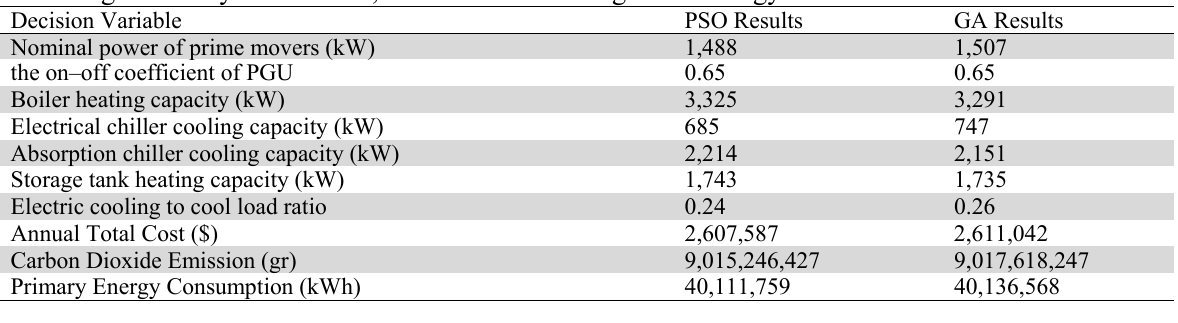
Best design of the system at FEL, fixed electric cooling ratio strategy